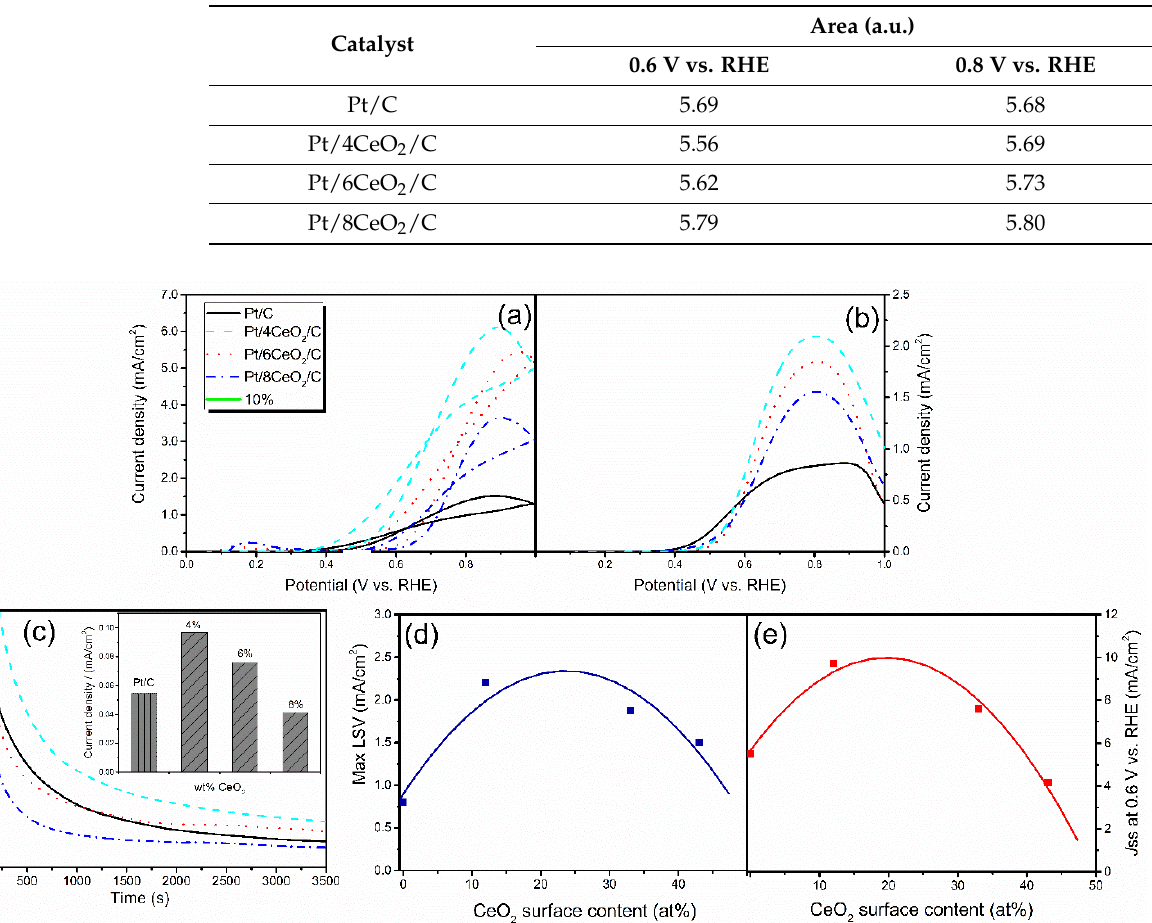
Table 4. Integrated intensity of the Lorentzian corresponding to the first maximum in the XANES spectra.